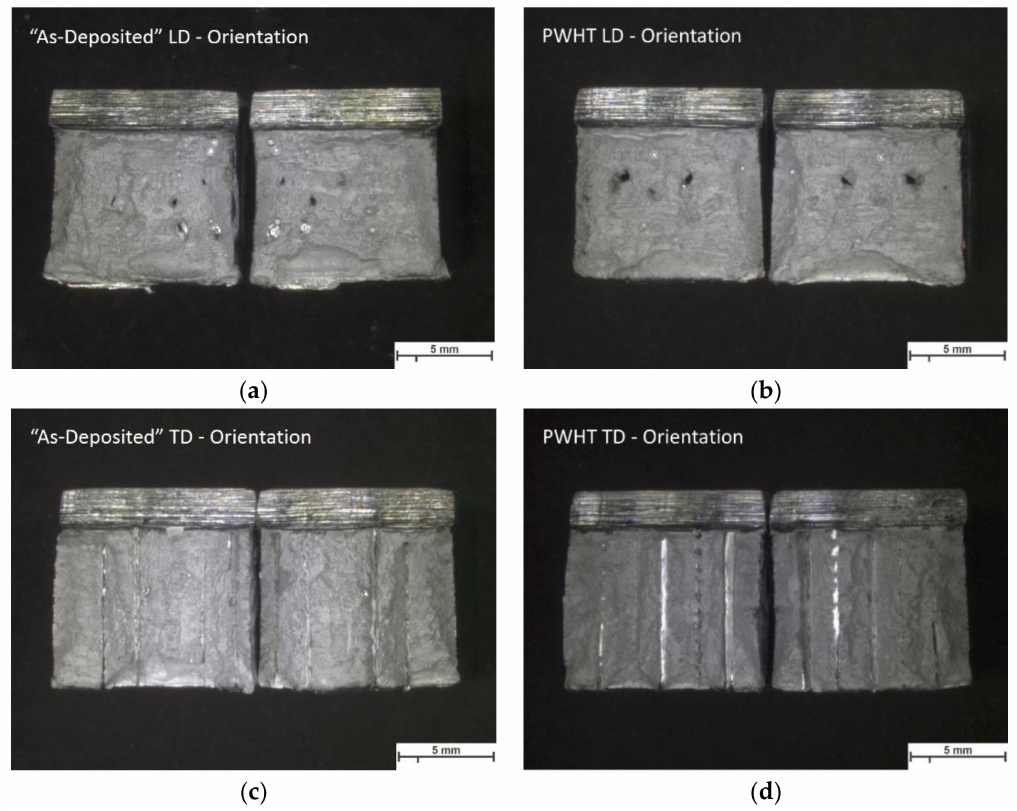
Figure 10. Stereo macrographs of the fractured surfaces in the ( a , c ) as-deposited and ( b , d ) PWHT condition of the tested longitudinal and transverse orientated Charpy V-notch